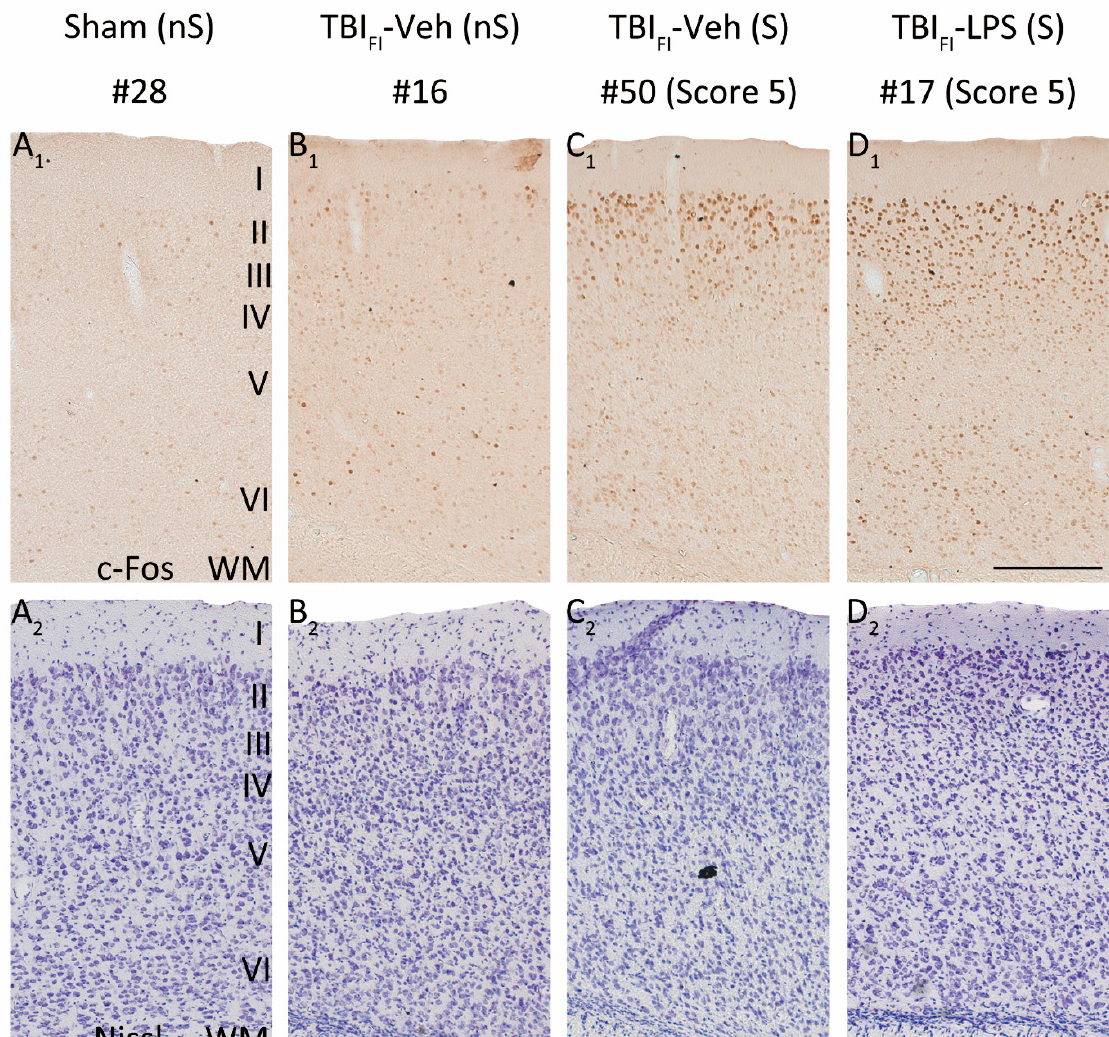
Figure 7. LPS enhances the seizure-induced c-Fos expression and changes its pattern in the caudomedial perilesional cortex. Representative high magnification photomicrographs showing c-Fos immunochemistry ( A 1 – D 1 ) and Nissl staining ( A 2 – D 2 ) in the caudomedial perilesional cortex in rats from the Sham-Veh and TBI FI endophenotype groups at 2 h after PTZ injection (23 weeks post-FPI and 15 weeks after LPS injection). ( A 1 , A 2 ) Example of a rat from the Sham-Veh group without PTZ-induced seizure (#28). ( B 1 , B 2 ) Example of a rat from the TBI FI -Veh group without a PTZ-induced seizure (#16). ( C 1 , C 2 ) Example of a rat from TBI FI -Veh group with a PTZ-induced seizure (#50, seizure Racine score 5). ( D 1 , D 2 ) Example of a rat from TBI FI -LPS group with a PTZ-induced seizure (#17, seizure Racine score 5). Note that in rats without a PTZ-induced seizure, TBI increased PTZ-induced c-Fos expression (( B 1 ) vs. ( A 1 )). In the TBI FI -Veh group, a rat with a PTZ-induced seizure ( C 1 ) exhibited higher c-Fos activation compared to a rat without a seizure ( B 1 ), particularly in the supragranular layers. In the TBI FI endophenotype with PTZ-induced seizure, LPS treatment at a chronic time-point after TBI further enhanced c-Fos expression ( D 1 ) compared with vehicle treatment ( C 1 ) in all layers. Abbreviations: FI, focal inflammatory; FPI, fluid-percussion injury; LPS, lipopolysaccharide; nS, no seizure; PTZ, pentylenetetrazole; S, seizure; TBI, traumatic brain injury; Veh, vehicle; WM, white matter. Scale bars = 200 µ